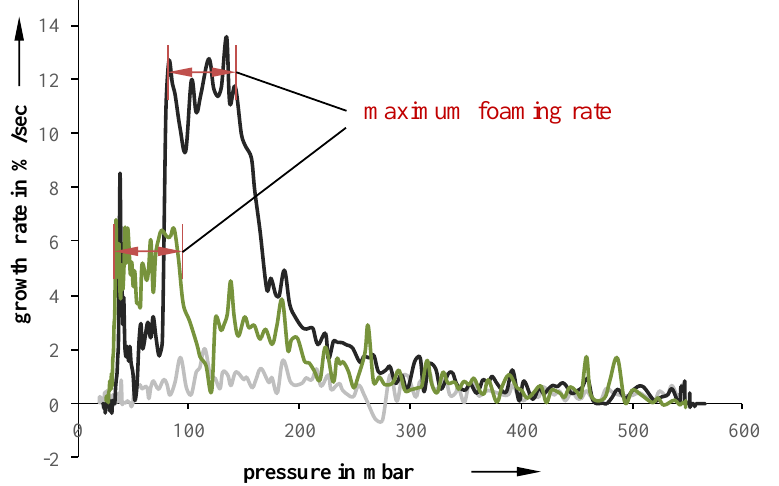
Figure 4. Foaming rate as a function of pressure for different temperatures at 10 mbar/s.